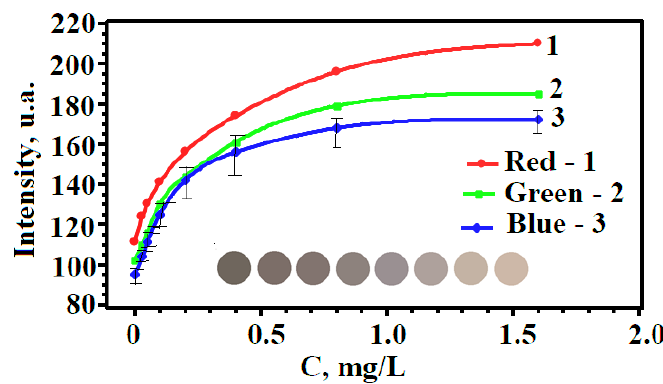
Figure 16. Changes in color and R-, G-, and B-color coordinates of Ag NPs-modified paper on the concentration of iodide ions in the analyzed solution.